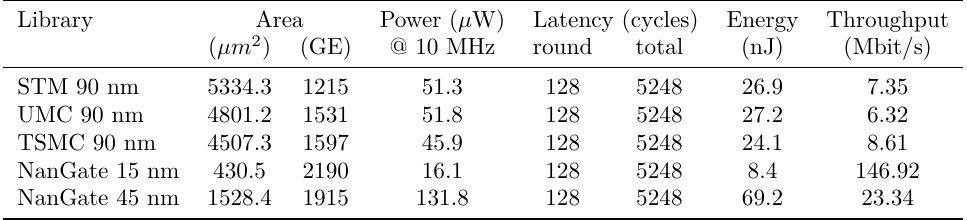
Table 14: Synthesis figures for the bit-serial GIFT encryption